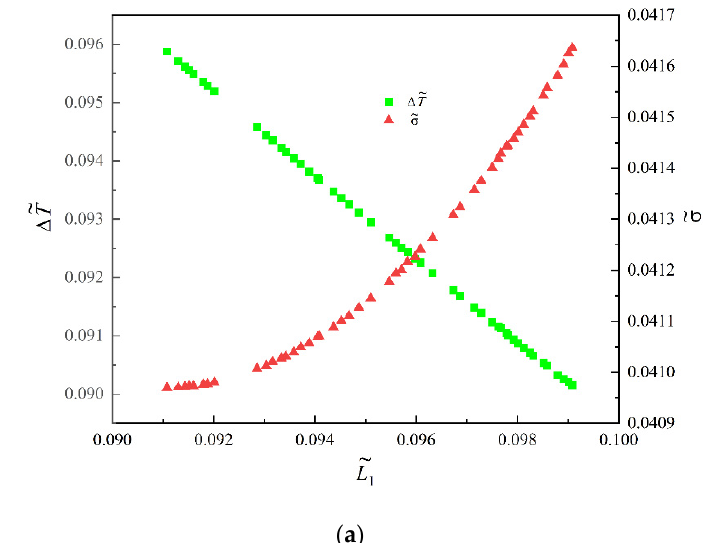
Figure 4. Pareto frontiers of ∆ (cid:101) T and (cid:101) σ with MOO under two-DOF optimization.